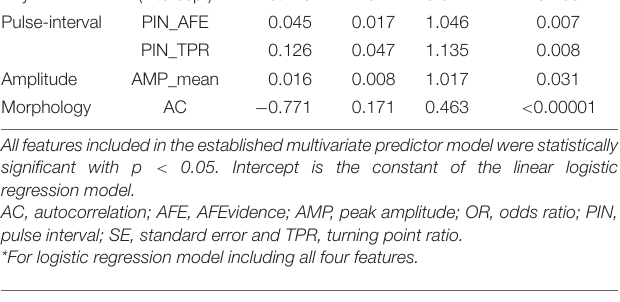
TABLE 5 | Multivariate predictor model 10-fold cross-validation diagnostic performance results in detection of atrial